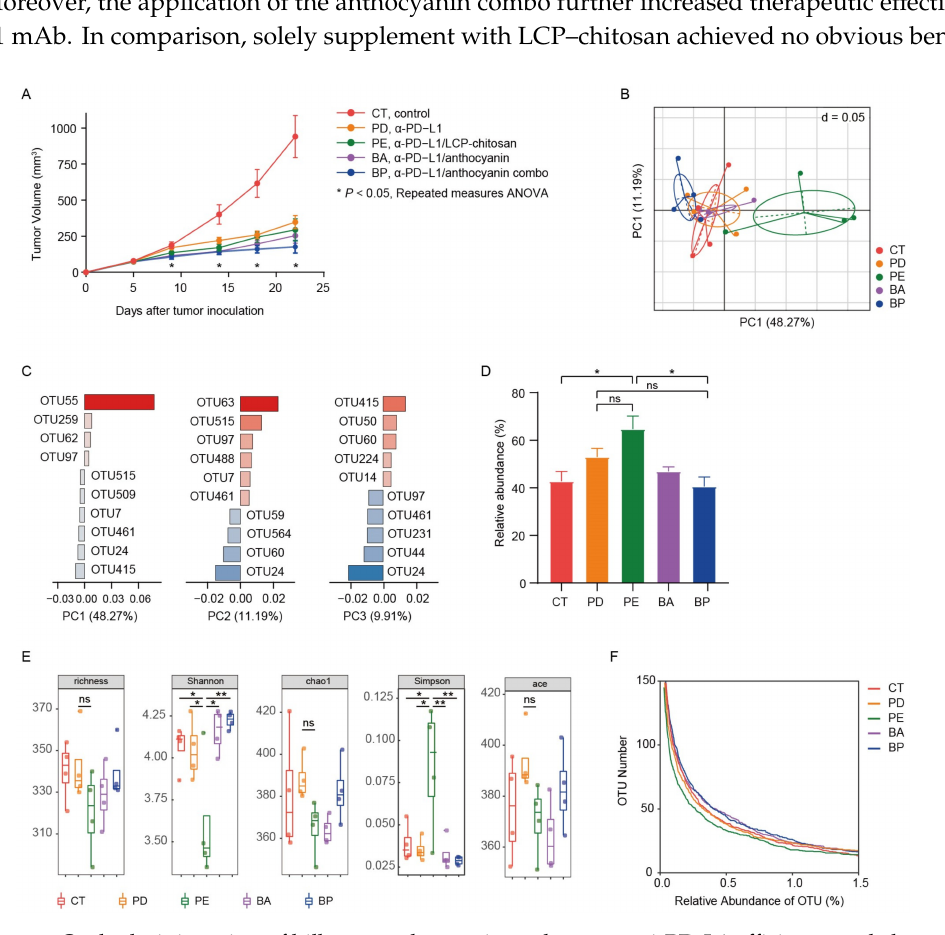
Figure 2. Oral administration of bilberry anthocyanins enhances anti-PD-L1 e ffi ciency and changes the mouse gut microbiome structure. ( A ) C57BL / 6 mice were inoculated subcutaneously with 5 × 10 5 MC38-OVA cells and treated with 200 µ g of the immunoglobulin G2b (IgG2b) isotype or the α -PD-L1 mAb on days 7 and 10. CT, the IgG2b isotype control; PD, the α -PD-L1 group; PE, the α -PD-L1 / LCP–chitosan group; BA, the α -PD-L1 / anthocyanin group; BP, the α -PD-L1 / anthocyanin combo group. Repeated measures ANOVA (time × tumor volume) and Sidak’s multiple comparisons test were used to test mouse tumor growth between groups. Data indicates mean ± SEM, n = 6 per group, * p < 0.05. ( B ) Beta-diversity analysis of microbial communities by using principal component analysis (PCA) based on OTUs. ( C ) The associated contribution plot illustrating the key OTUs that impact the PCA clustering. ( D ) Significant increase of Muribaculaceae in the α -PD-L1 / LCP–chitosan group. ( E ) For alpha diversity, richness, chao1, Shannon, Simpson, and ace indices were calculated using random subsamples of 35,043 sequences per sample, Data indicates mean ± SEM. * p < 0.05, ** p < 0.01 (Student’s t -test). ( F ) OTU richness under di ff erent thresholds of relative